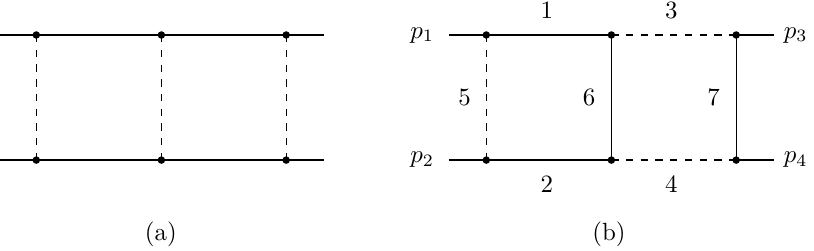
Figure 1 . Planar graphs of the first and the second type for two-loop Bhabha scattering. Solid (dashed) lines indicate massive (massless) propagators. All the external momenta are